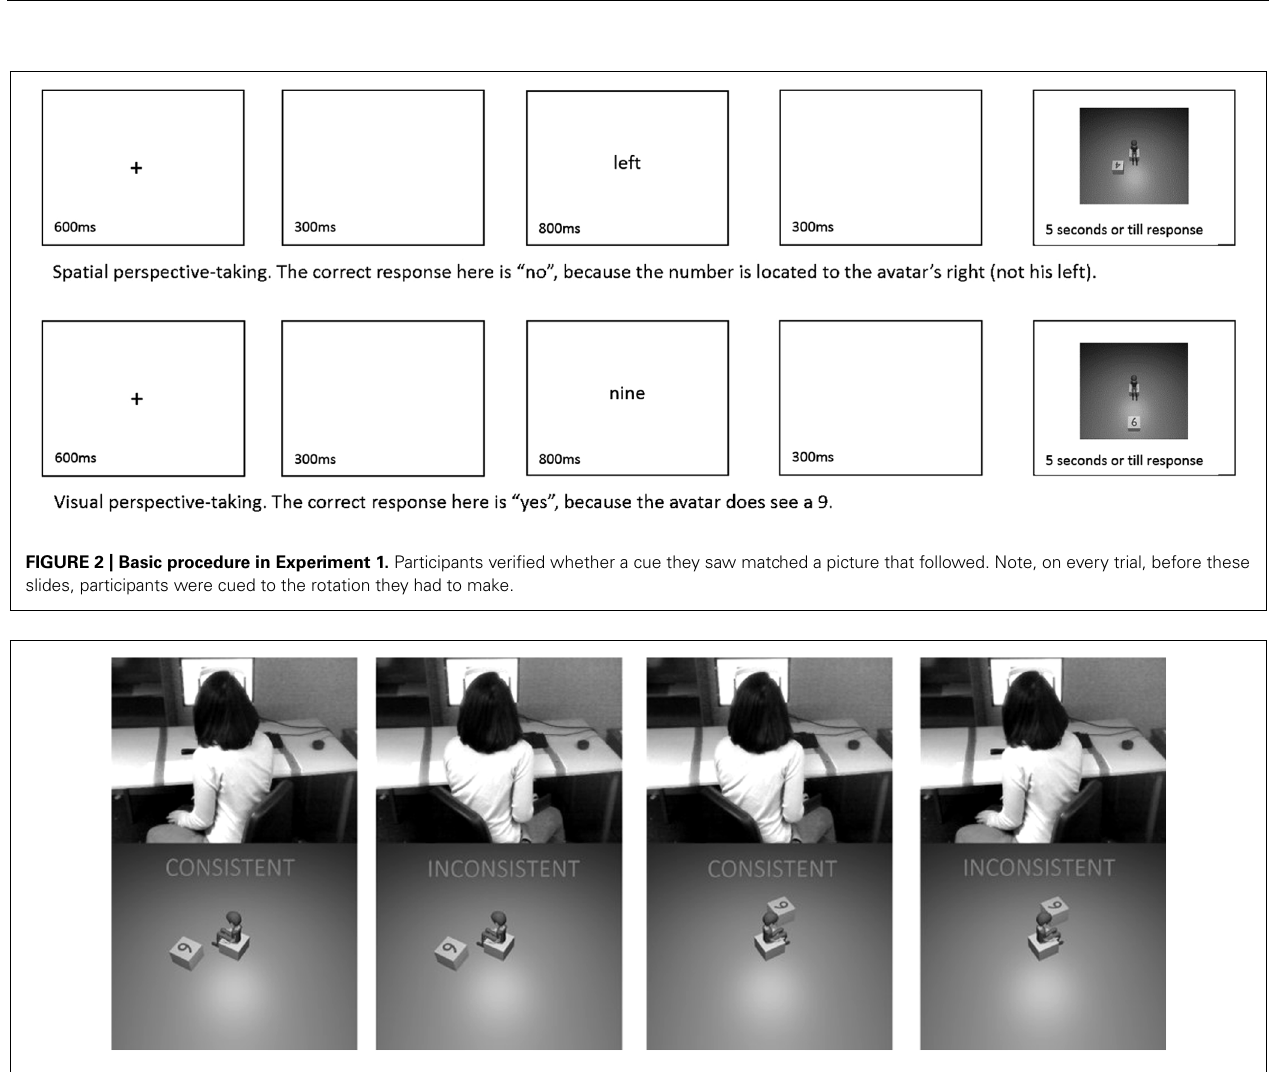
clockwise turn has the opposite effect. Note how the specific picture stimulus, the direction of the turn and the visual impression for the participant are independent of